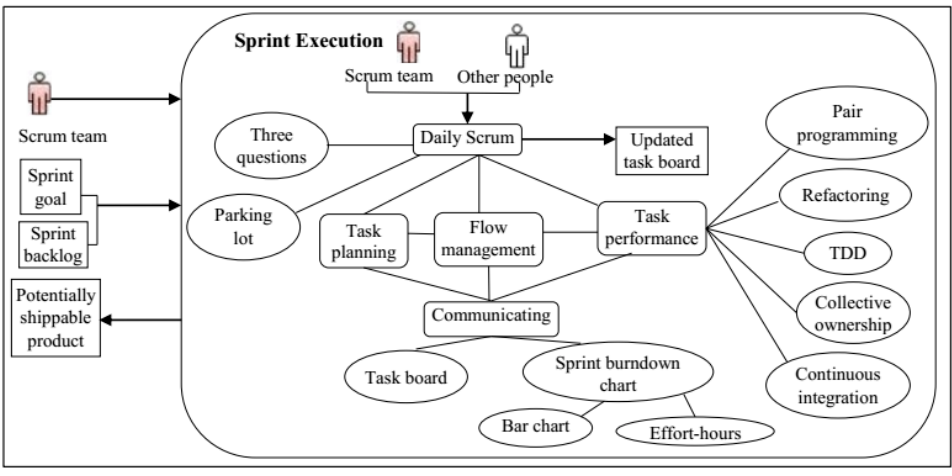
Figure 16. Output of the tool.